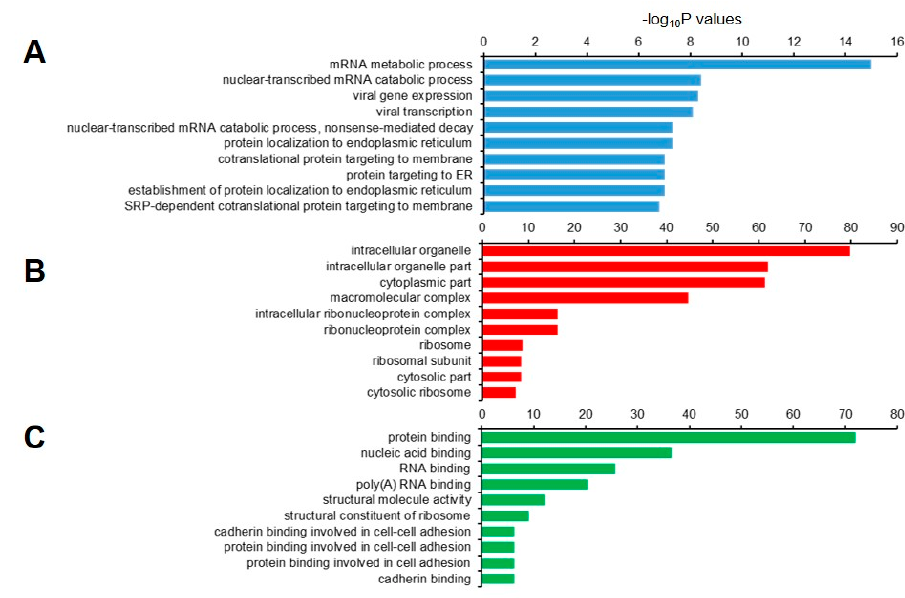
Figure 8. Gene ontology (GO) enrichment analysis of 1,877 decapped transcripts. The top 10 ( A ) biological process; ( B ) cellular component, and ( C ) molecular function GO terns are represented.